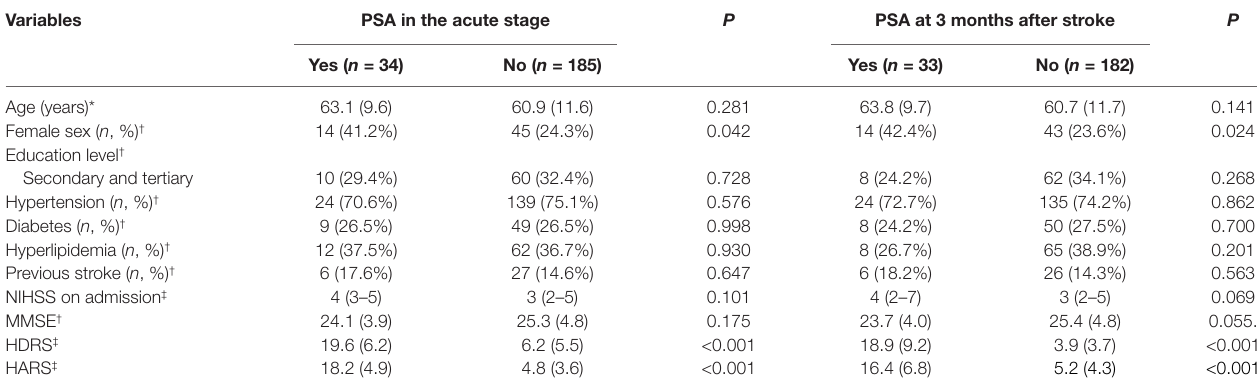
TABLE 1 | Comparisons of demographic and clinical variables between the PSA and non-PSA groups. Variables PSA in the acute stage P PSA at 3 months after stroke